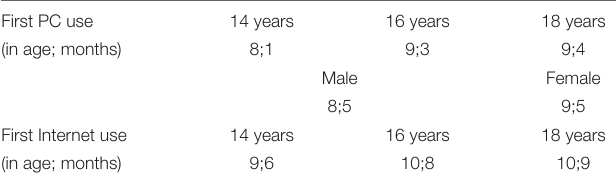
TABLE 1 | Small media use biography ( N = 134). TABLE 2 | Computer and Internet competence.